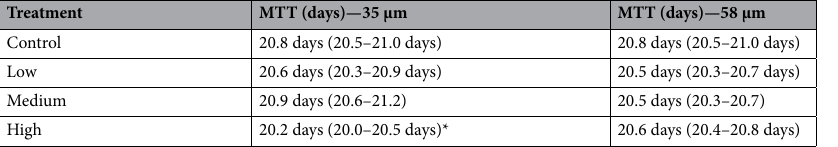
Table 1. Median transformation time (MTT) and 95% confidence intervals for the 35 and 58 µm polyethylene microspheres treatments. *Denotes transformation treatment that was significantly faster than the control.